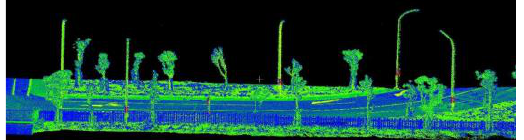
Figure 2. Points cloud data in the experiment field without curb structure.